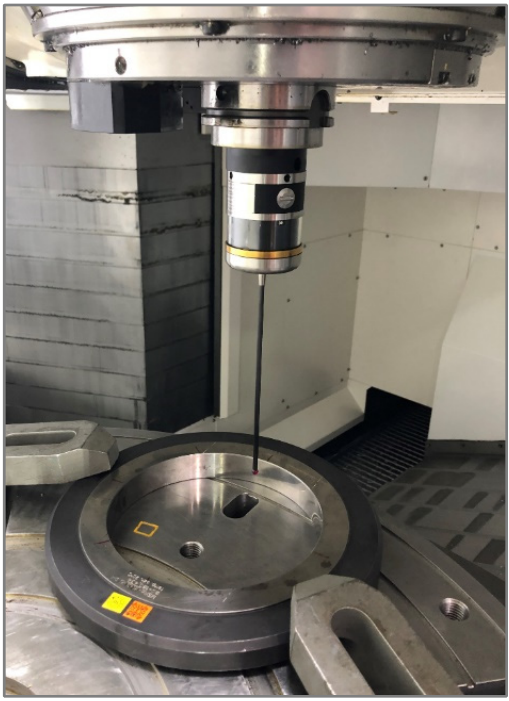
Figure 6. Test setup of ring gauge DIA. 180.4410 mm for initial R&R probing system performance analysis, repeatability, and reproducibility, T1 TTP.